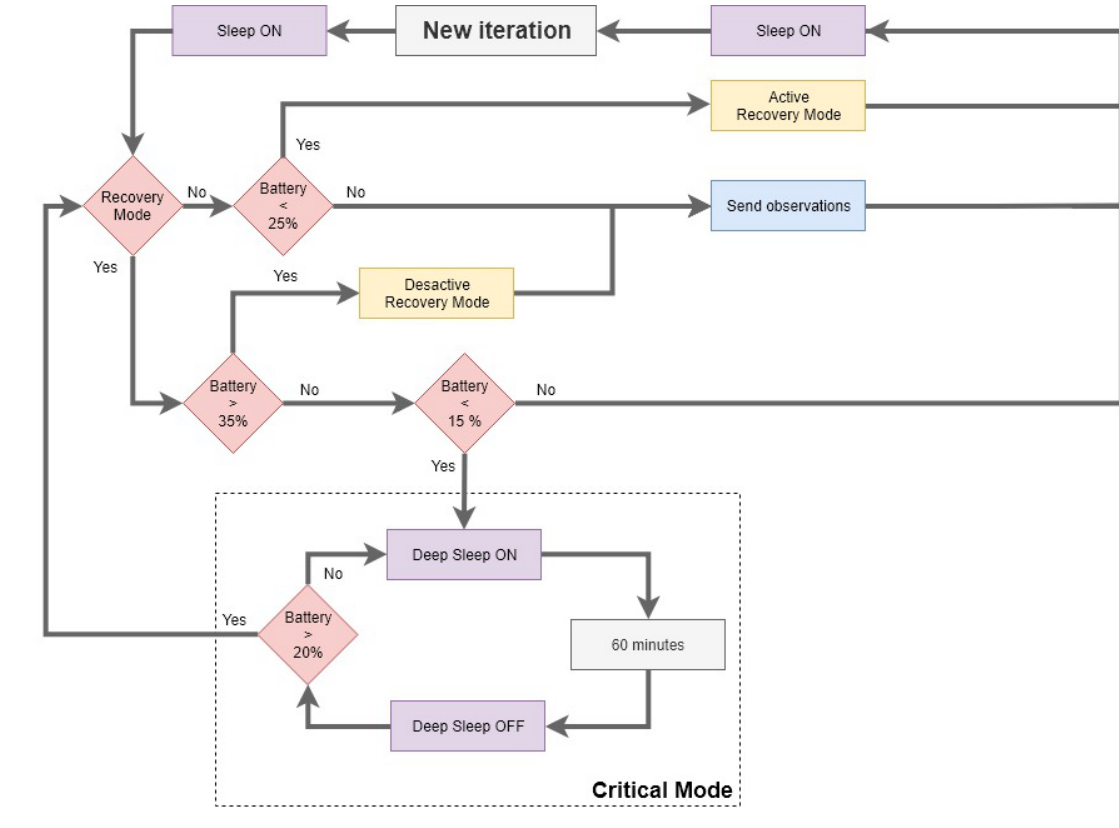
Figure 8. Energy modes